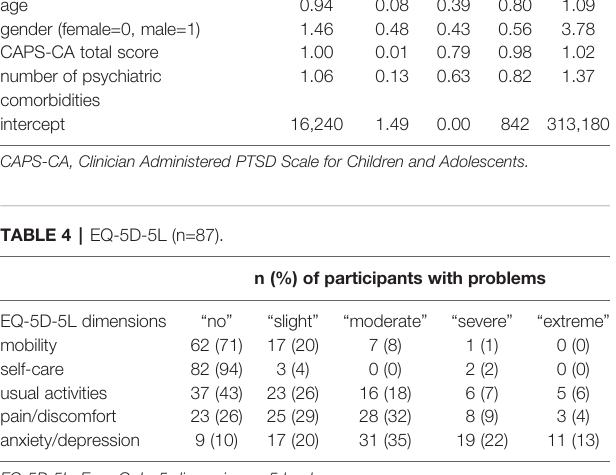
( Table5 ).Neithergender,theCAPS-CAtotalscorenorthenumber